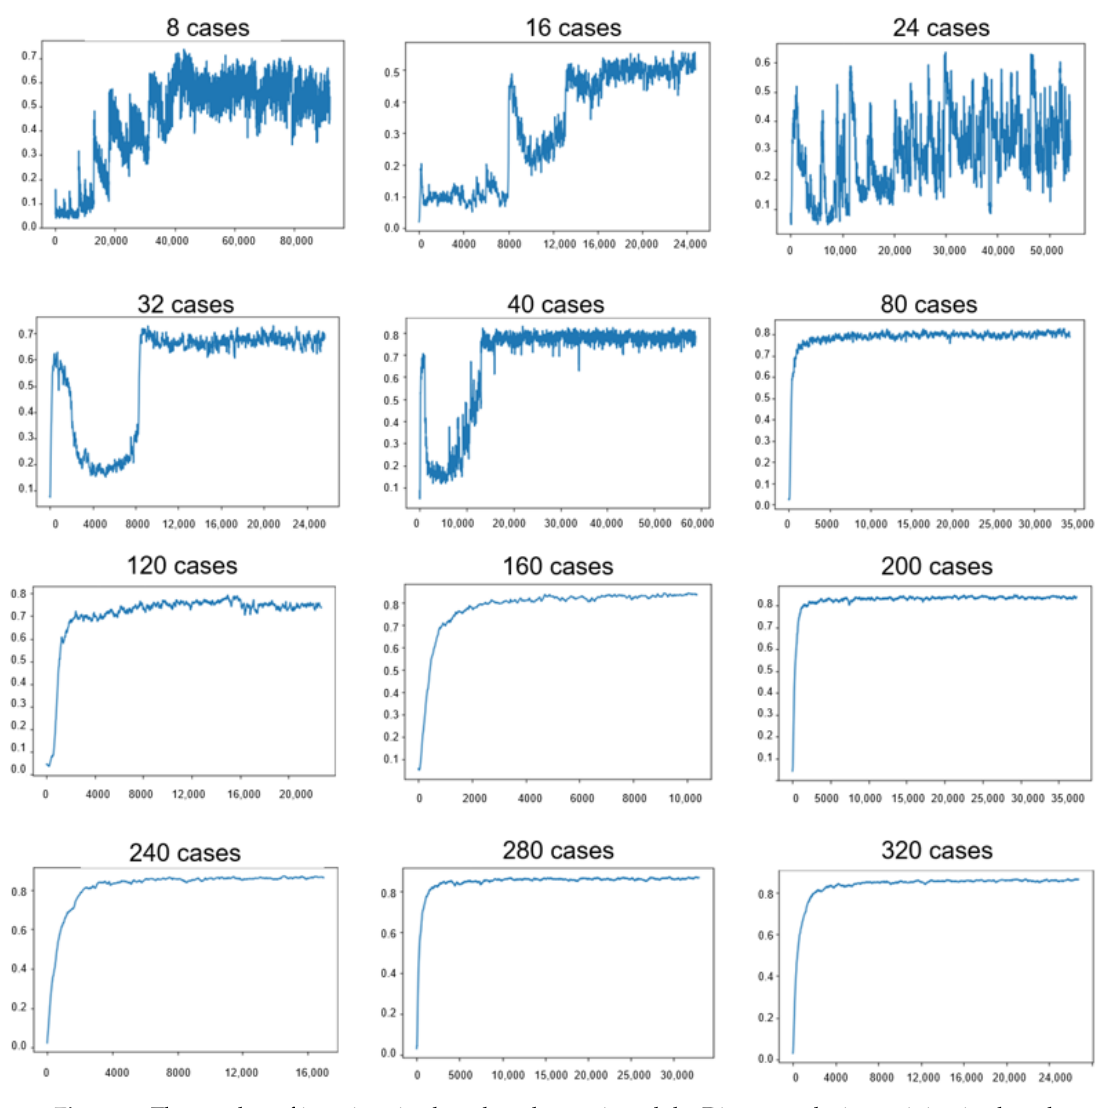
Figure 5. The number of iterations is plotted on the x -axis and the Dice score during training is plotted on the y -axis. The mean Dice score was plotted during training for the 12 different dataset sizes. The Dice score exhibited instability when training on case sizes of 8, 16, 24, 32, and 40. The Dice score stabilized more easily on case sizes of 80, 120, 160, 200, 240, 280, and 320. The Dice score variance was calculated during training; the run with 40 cases had the highest variance of 0.046 and the run with 200 cases had the lowest variance of 0.003.